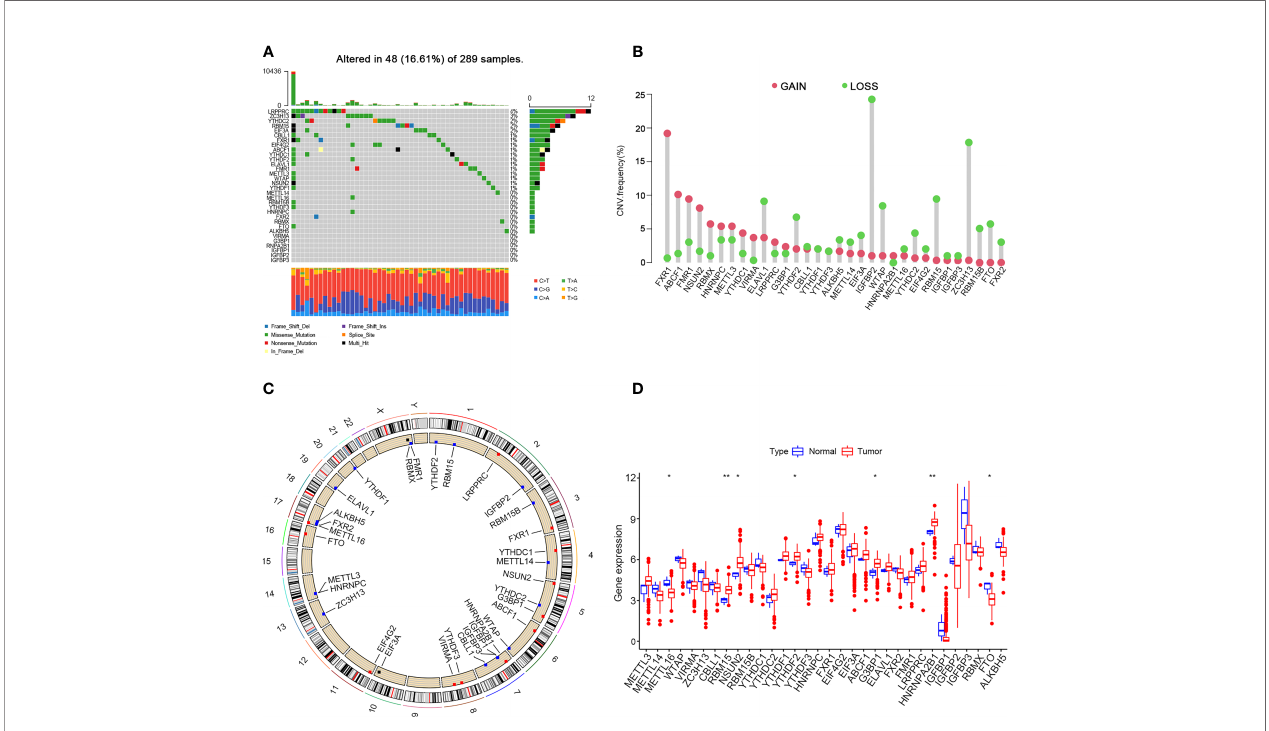
FIGURE 1 | Landscape of genetic and expression variation of m6A regulators in cervical cancer. (A) 48 of 289 samples have genetic alterations of 32 m6A regulators. (B) Copy number variation mutation frequency of m6A regulators. (C) Position of copy number variation change of m6A regulators on human chromosome. (D) Difference in the expression level of m6A regulators between normal and tumour samples (*P < 0.05 and **P <